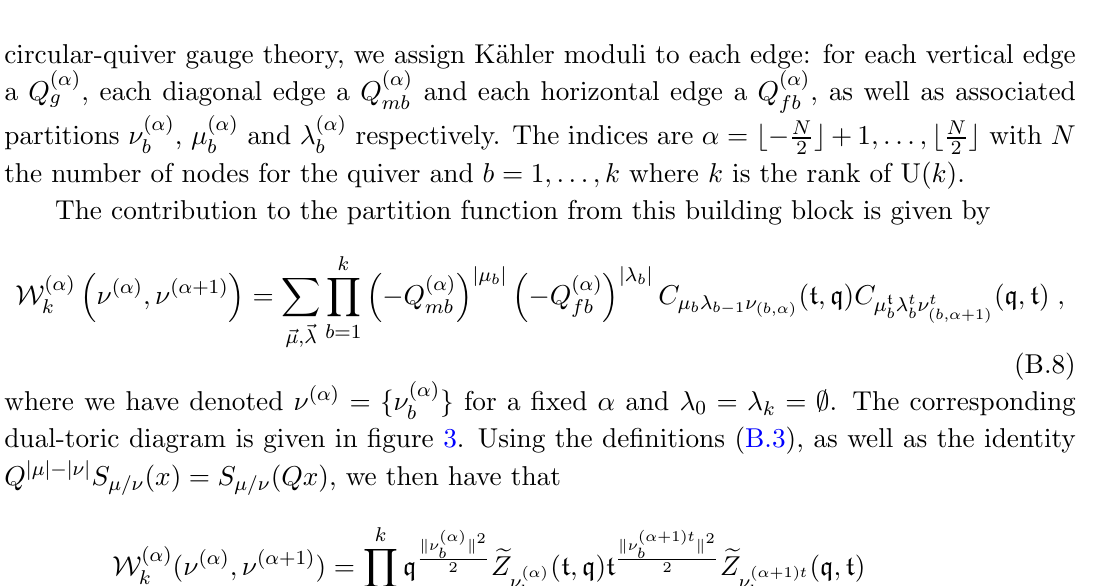
Figure 3 . The “strip geometry” for the U( k ) N theory. The preferred direction is highlighted in red. There are no non-trivial framing